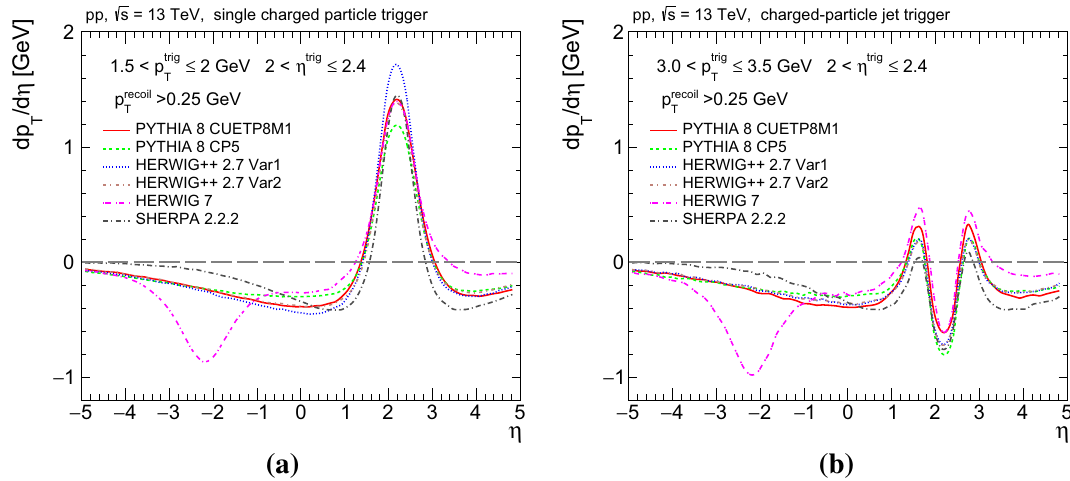
Fig. 6 Rapidity correlation of recoiled system with respect to single-charged particle with 1 . 5 ≤ p T < 2 . 0 GeV ( a ) and with respect to charged- √ s = 13 particle jet with 3 . 0 ≤ p T < 3 . 5 GeV ( b ) at